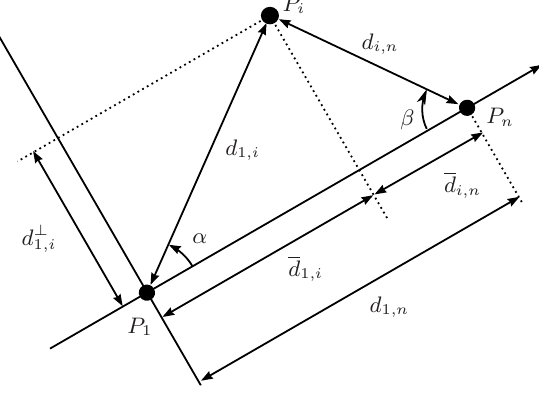
Figure 3. Projecting distances on the axis defined by P 1 P n and on its orthogonal